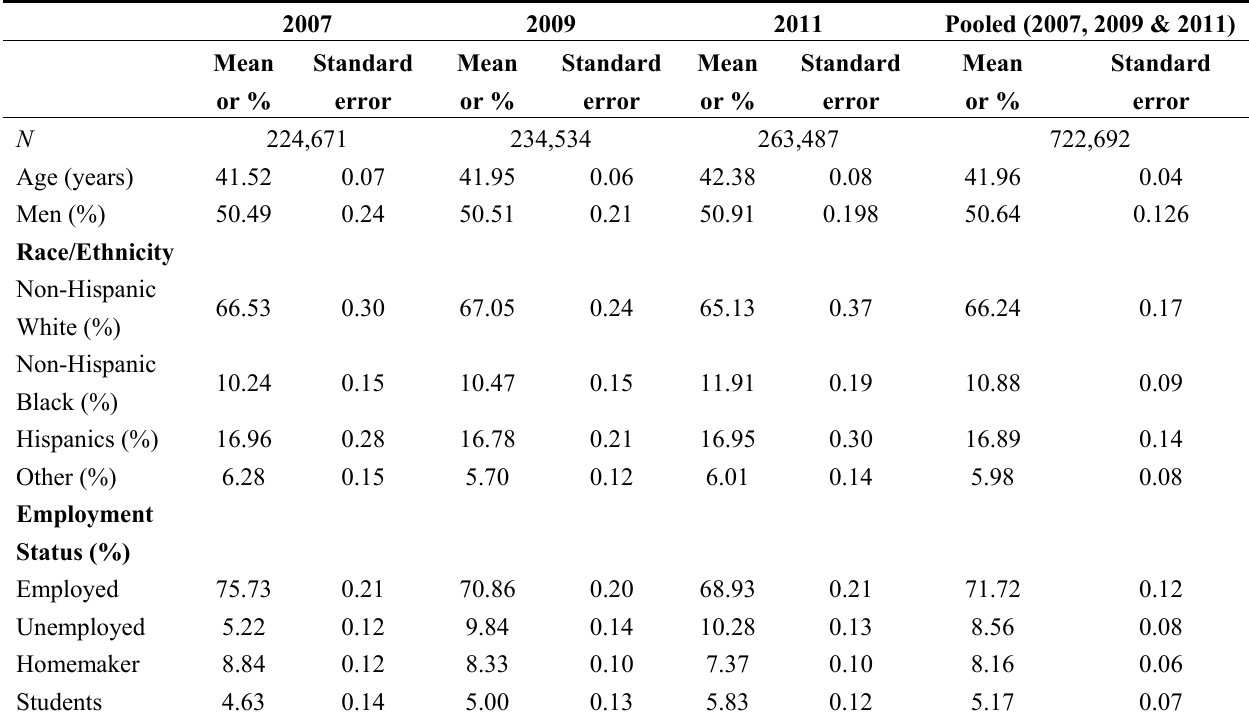
Table 1. Descriptive Statistics of the Behavioral Risk Factor Surveillance System (BRFSS) 2007, 2009 and